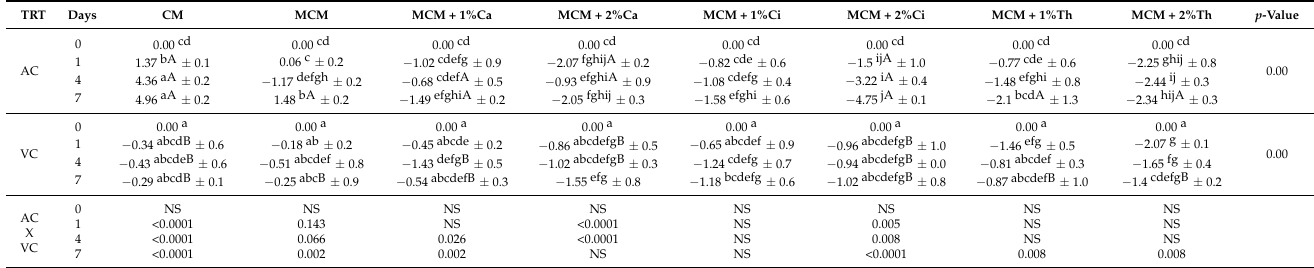
Table 10. Population changes of Pseudomonas (log (N0/N) ± SD CFU/g) in marinated camel meat with essential oils under aerobic (AC) and vacuum (VC) conditions after storage at 10 ◦ C for 0, 1, 4 and 7